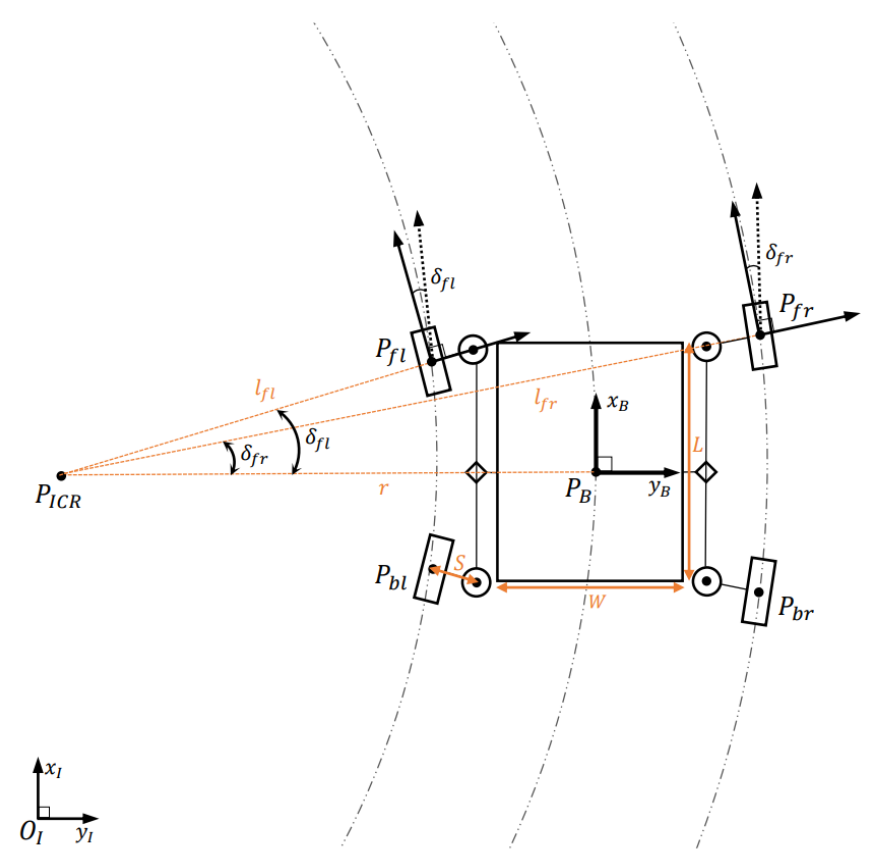
Figure 4. An illustration of the kinematic model ( r < 0 ) under the non-slip condition.